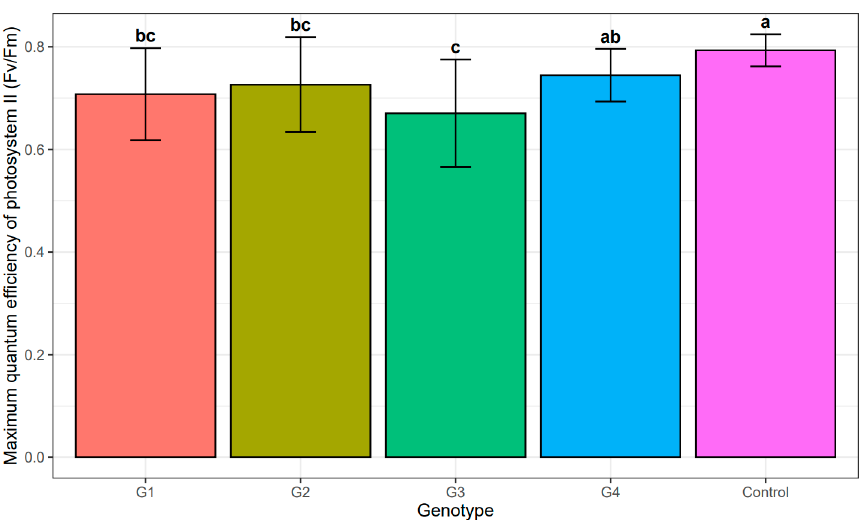
Figure 6. Mean value and standard deviation of maximum quantum efficiency of photosystem II (Fv/Fm) of individual genotypes: G1–G4 under the influence of salinity and control. The same letters indicate lack of statistically significant differences ( p <